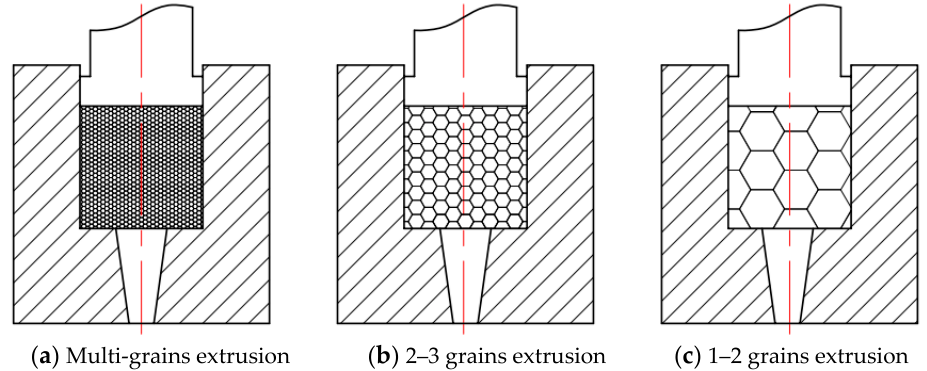
Figure 13. Schematic diagram of V type hole micro extrusion forming models with different extruded grains.